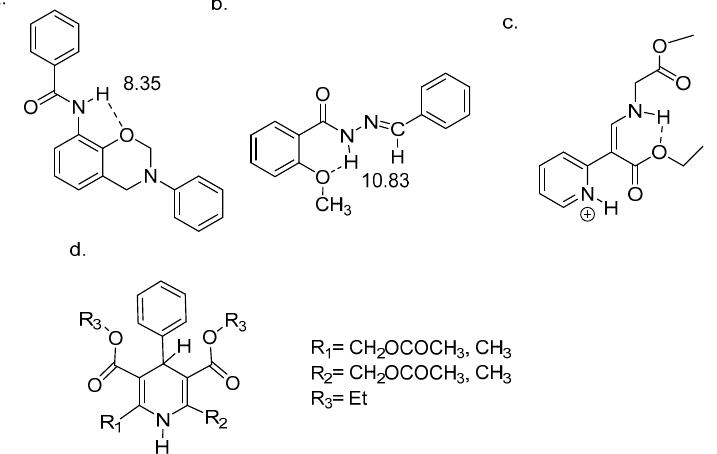
Figure 14. Hydrogen bonding to single bonded oxygen. ( a ). Benzoxazine with intramolecular hydrogen bonding from [47]. ( b ). N’-benzylidenbenzohydrazide from [48]. ( c ). Protonated enamine molecular switch from [49]. ( d ). 1,4 ‐ dihydropyridine derivatives from [50]. The numbers are the NH chemical shifts in ppm.